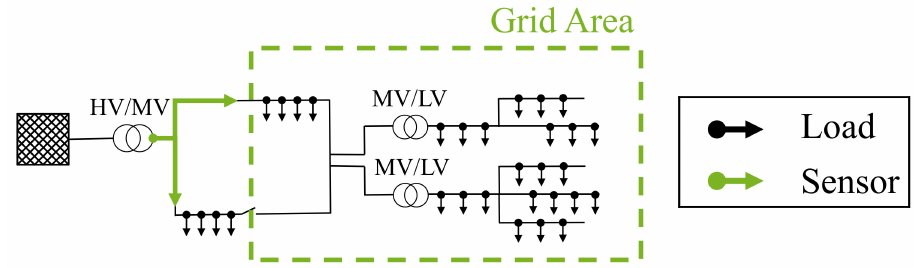
Figure 3. One example of a medium voltage grid area with di ff erent load